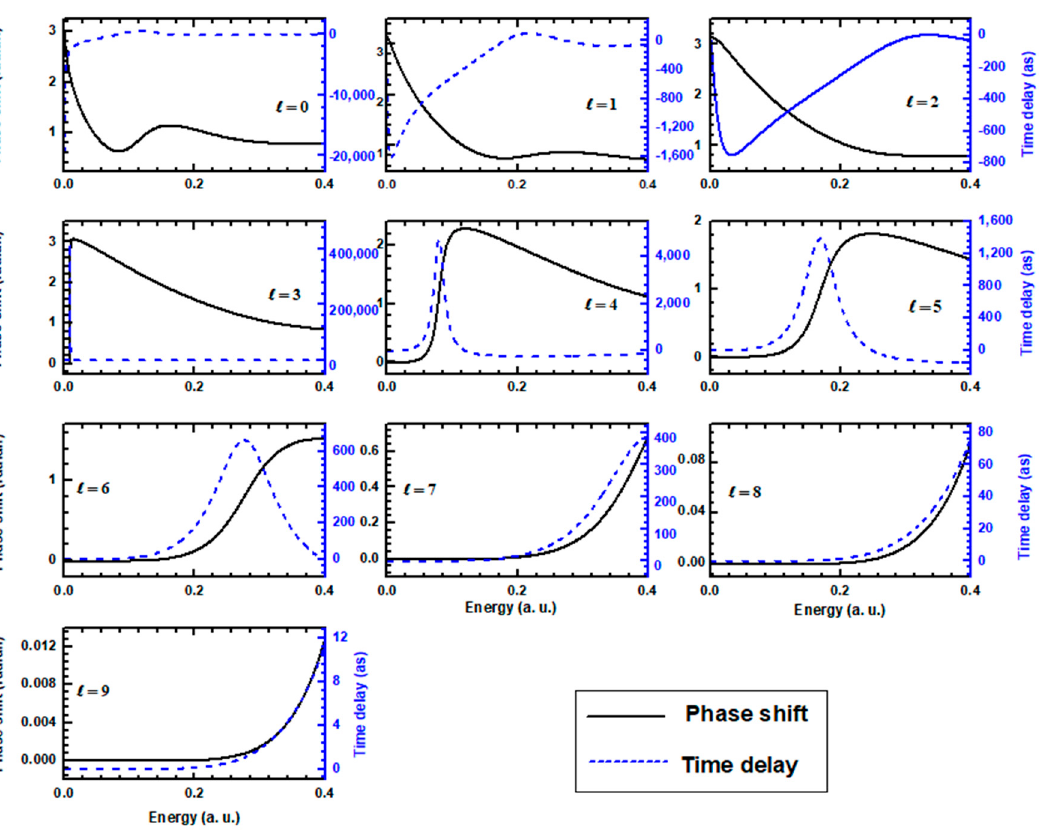
Figure 3. Scattering phase shift and EWS time delay plotted for partial waves with (cid:96) = 0–9. The solid black line shows the phase shift (left axis), and the dashed blue line indicates the time delay (right axis).